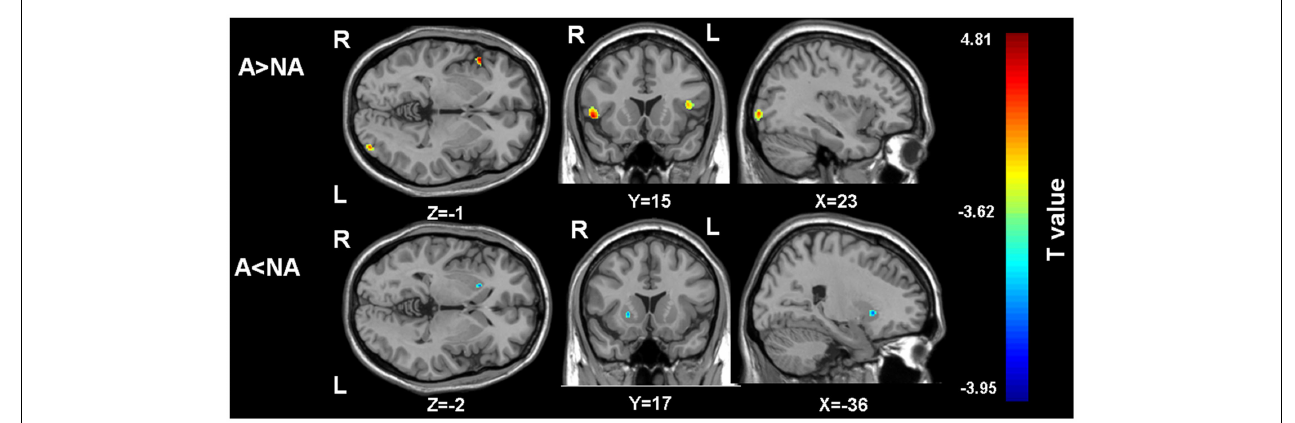
showing larger gray matter volumes in the apathy group compared to the non-apathy group. A < NA: the regions showing larger gray matter volumes in the apathy group compared to the non-apathy